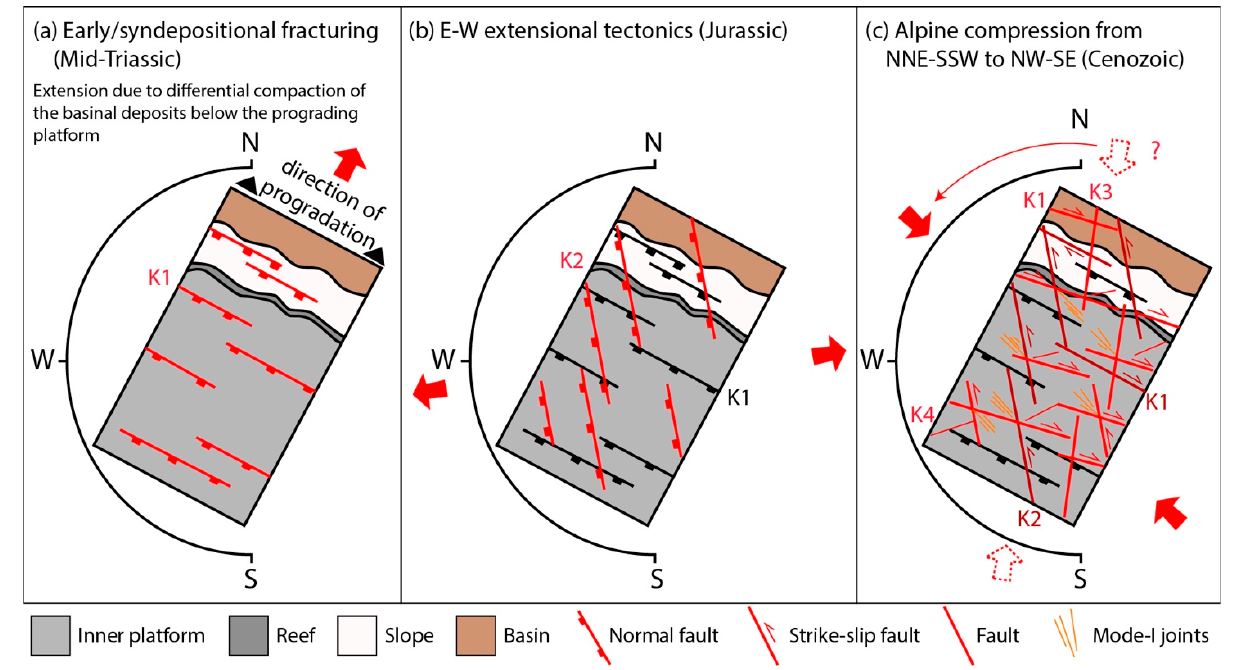
Figure 17. Sketch of the main deformational phases that affected the platform of Lastoni di Formin: ( a ) K1 faults and fractures formation due to the early/syndepositional fracturing driven by differential compaction processes; ( b ) K2 faults and fractures formation due to the Jurassic E ‐ W extensional tectonics; ( c ) K1 and K2 fault and fracture reactivation and K1, K3, and K4 faults and fractures formation due to the NNE ‐ SSW to NW ‐ SE Alpine compression (Cenozoic).